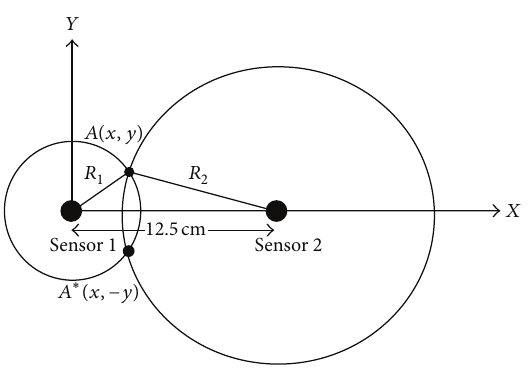
Figure 17: Behavior of output voltage from the two sensors.